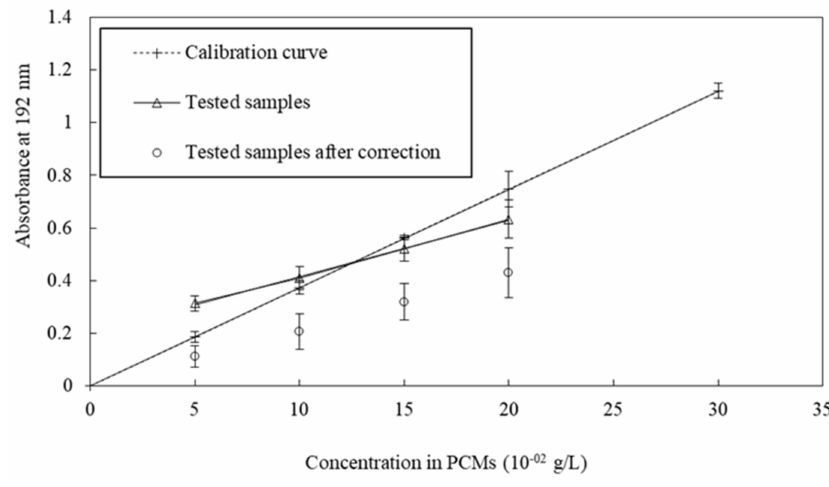
Figure 4. Comparison of tested samples with calibration